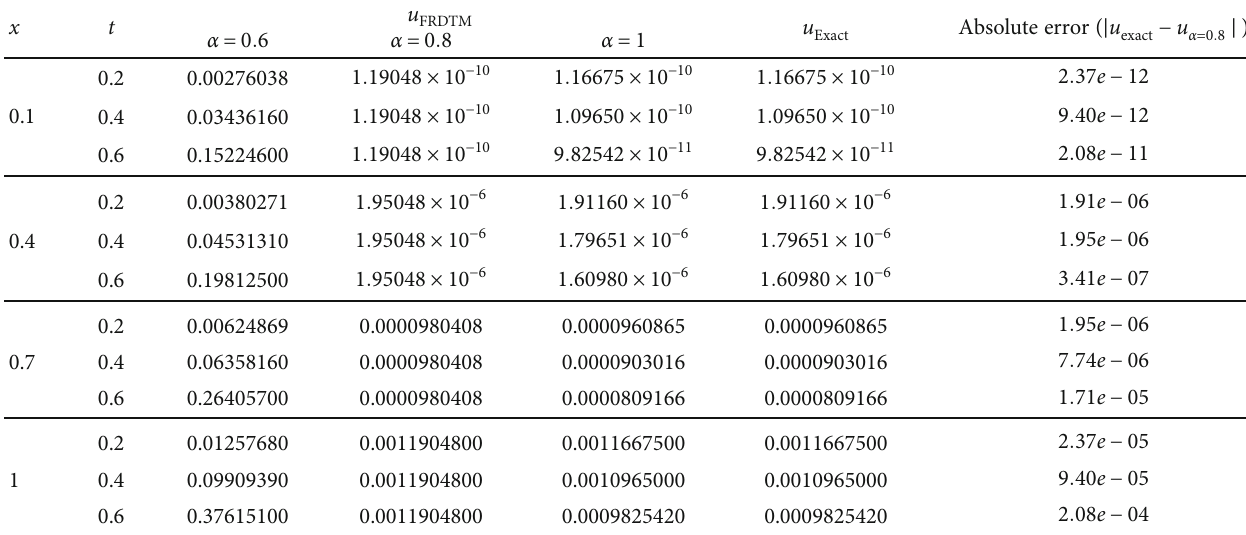
Table 2: Eighth-order approximate numerical solution by FRDTM of Eq. (28) at di ff erent values of α and comparison of absolute error at α = 0 : 8